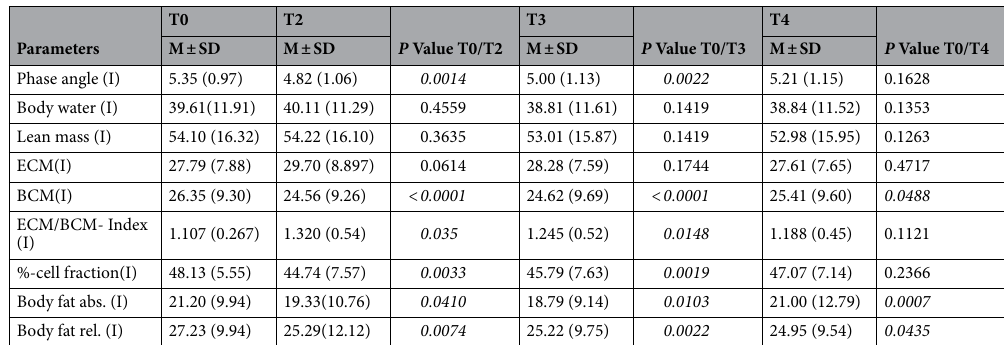
Table 2. BIA at measurement times T0 (preoperative), T2 (before discharge), T3 (3 months postoperative) and T4 (6 months postoperative) in intervention group. Significant values are in italics. M = mean, SD = standard deviation, I = intervention